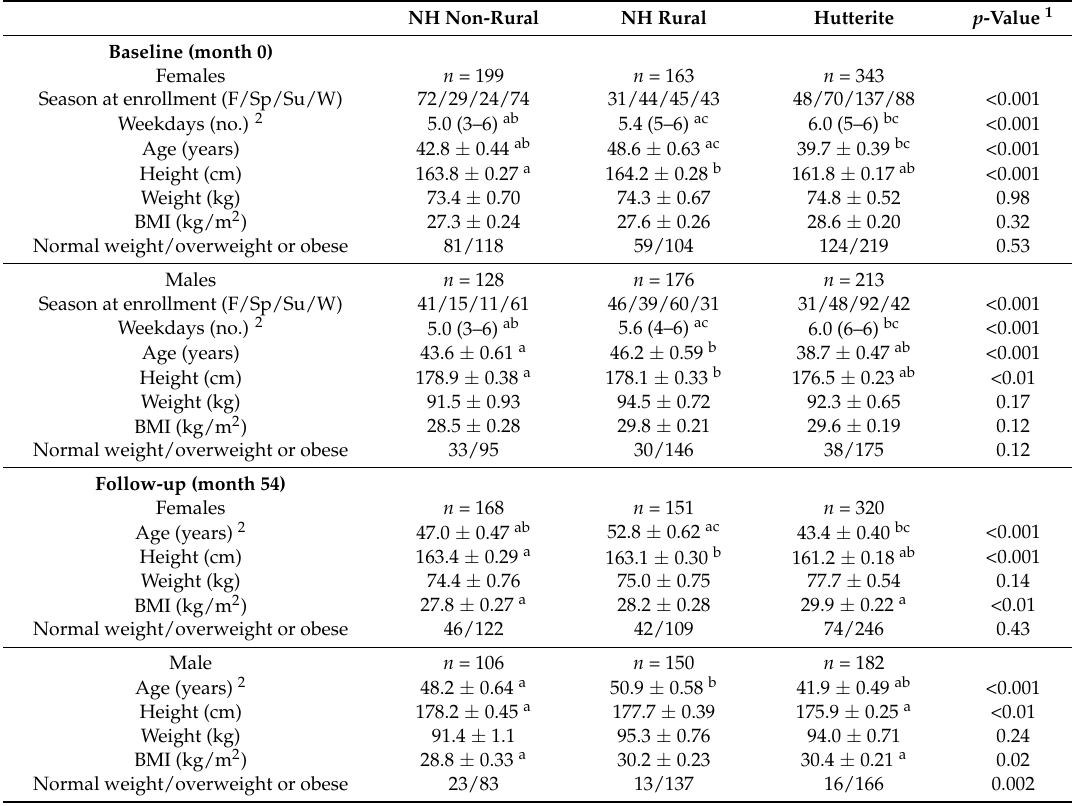
F, fall; Sp, spring; Su, summer; W, winter; BMI, body mass index; NH, non-Hutterite. 1 Overall differences among groups examined using one-way ANOVA or chi-square; means with similar superscripts are different at p ≤